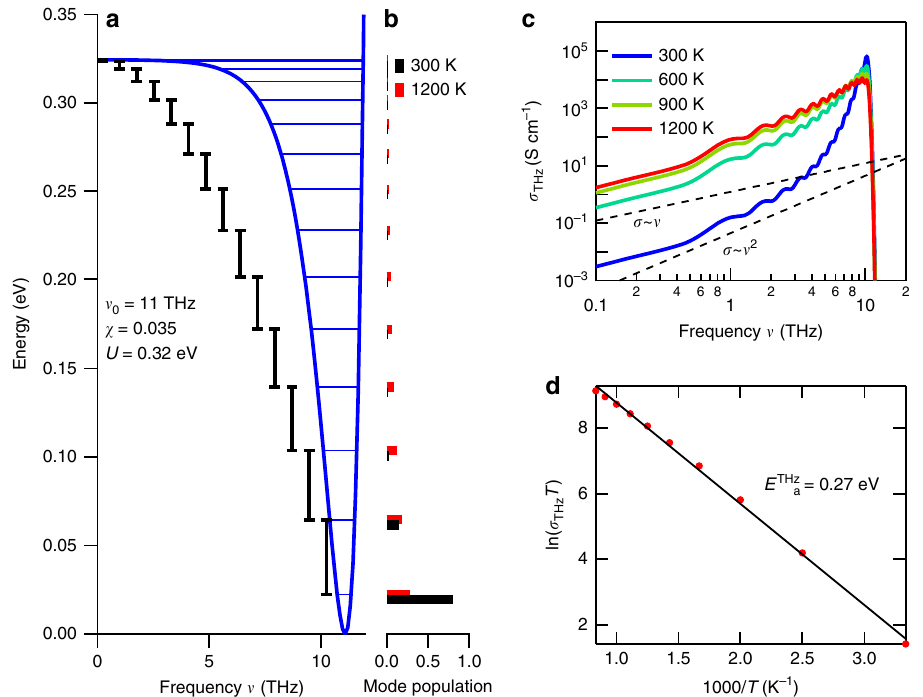
Fig. 5 THz ion motions in the Morse potential. a The simpli fi ed potential shape and energy levels for the localized vacancy mode with ν 0 ¼ 11 THz and χ ¼ 0 : 035. b The populations of the energy levels are shown in black and red for 300 and 1200 K, respectively. c The calculated conductivity spectra for the localized vacancy mode. d The Arrhenius plot for the calculated THz conductivity at 0.36